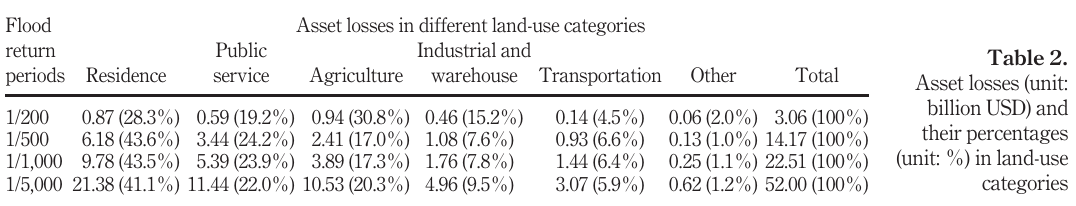
Table 2. Asset losses (unit: billion USD) and their percentages (unit: %) in land-use